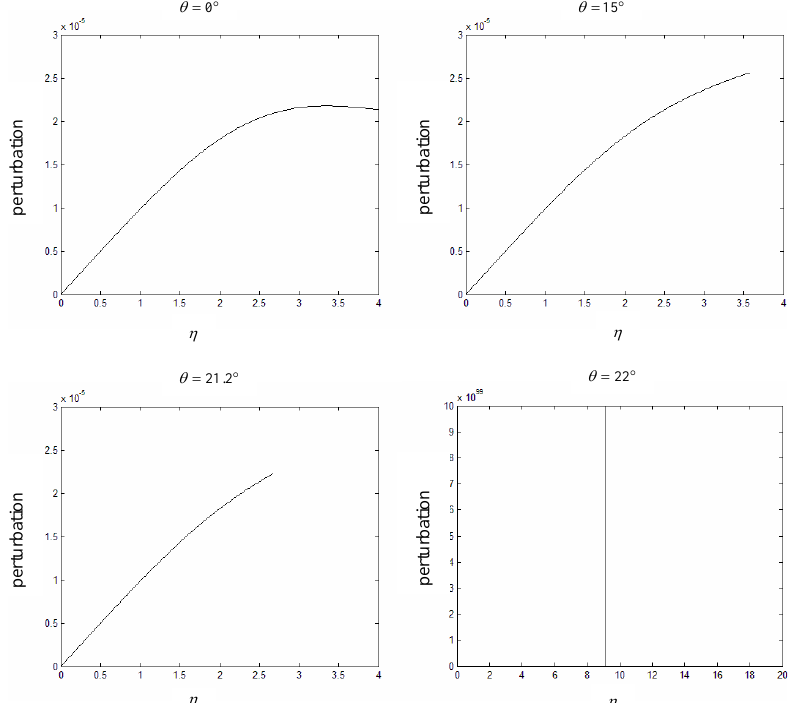
Fig. 4. The difference between the original and perturbed initial conditions is plotted against increase in non-dimensional distance from the plate surface η . It is observed that at the wedge angle of 22 ◦ , the difference between the trajectories in phase space blows up.